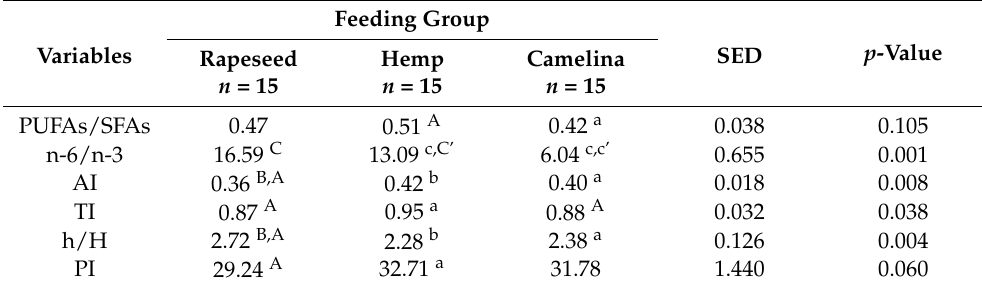
Table 7. Effects of diets on fatty acid ratios and lipid quality indices in egg yolk lipids of different quail